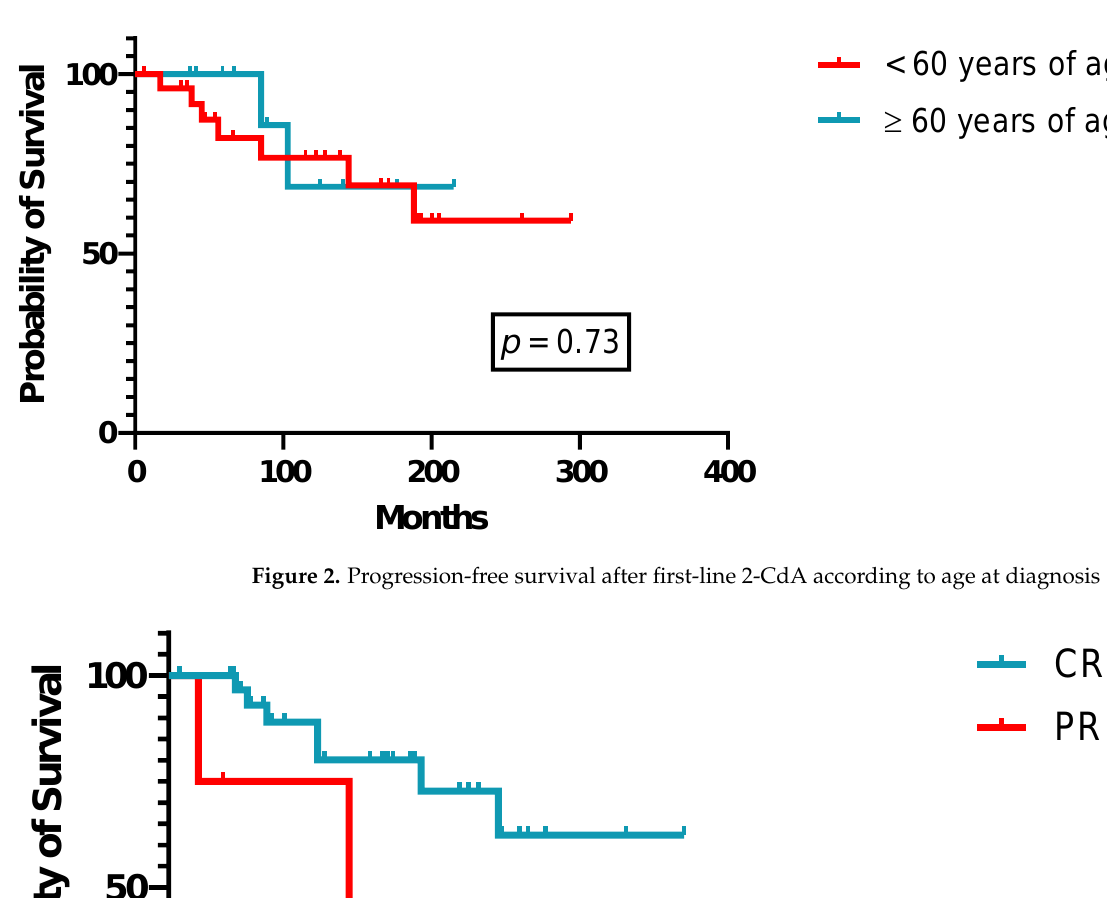
Figure 2. Progression-free survival after first-line 2-CdA according to age at diagnosis ( n = 42).